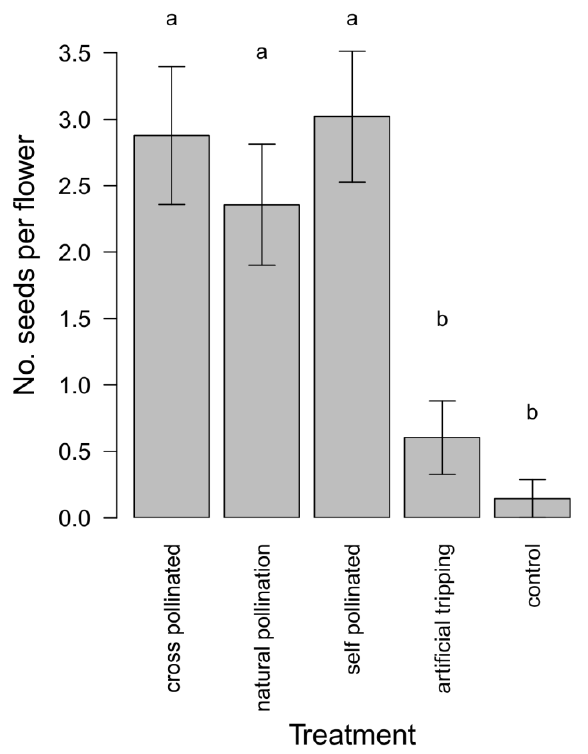
F IGURE 2. Mean number of seeds produced per flower of D. setigerum following pollination treatments. Error bars indicate standard error, and letters indicate significant differences (P < 0.05). N = 270 flowers (54 flowers per treatment).